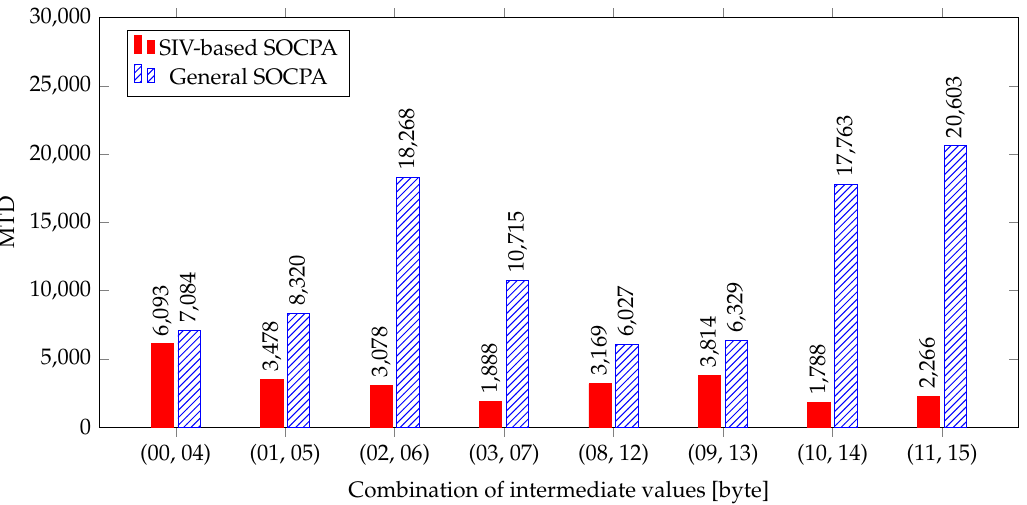
Figure A3. Minimum trace to disclosure (MTD) for MixColumns